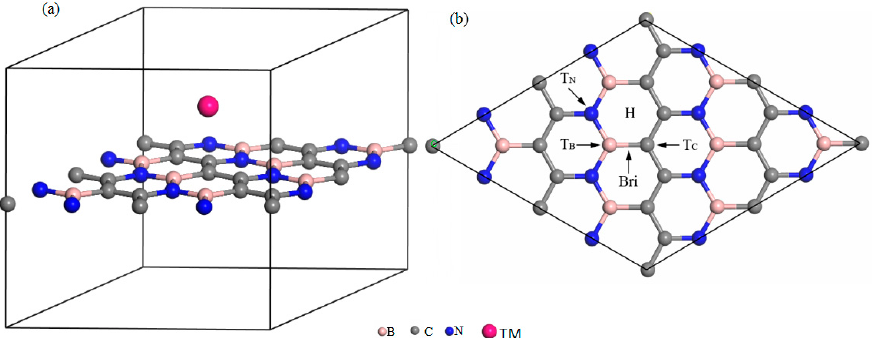
Figure 1. ( a ) The transition metal atom adsorption monolayer BC 2 N, ( b ) different adsorption sites of a single transition metal (TM) atom adsorbed on two-dimensional BC 2 N.